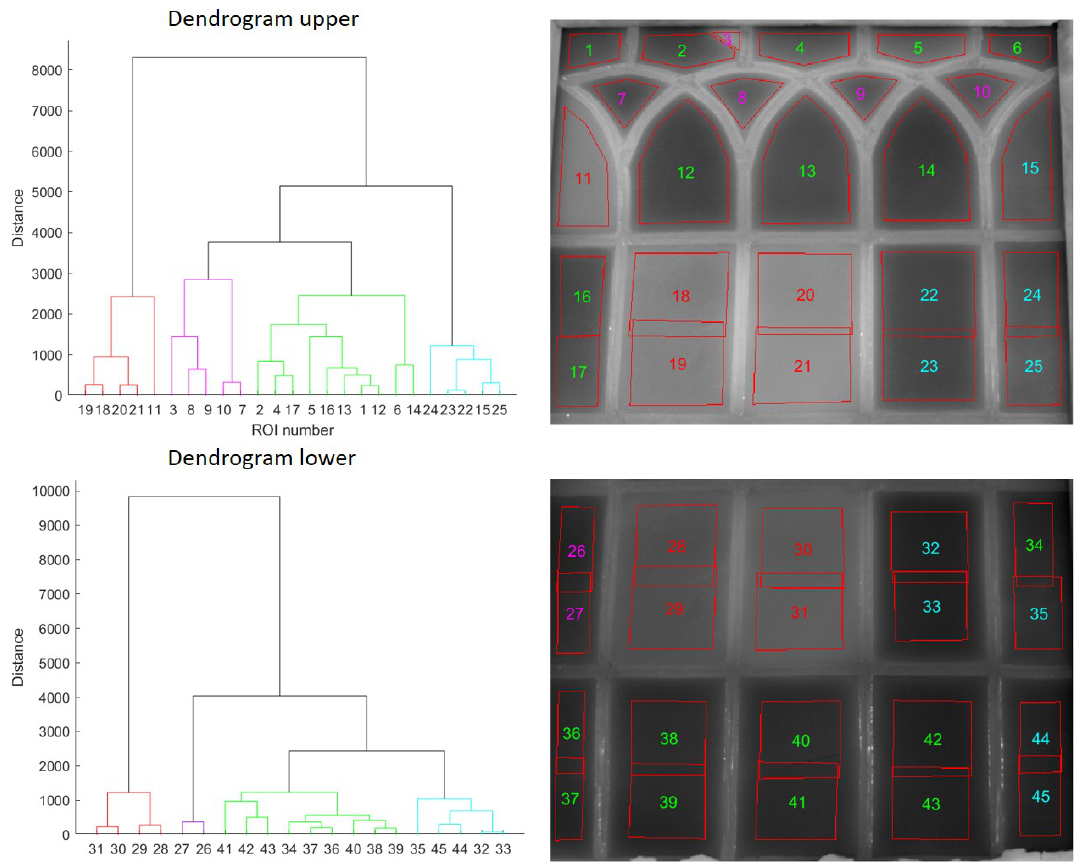
Figure 7. Left column: Dendrograms from hierarchical cluster analysis on the reflection mode measurements. Right column: The corresponding ROIs are marked with a red frame in the images next to each dendrogram. Each dendrogram was split into multiple clusters, each cluster is indicated by a different